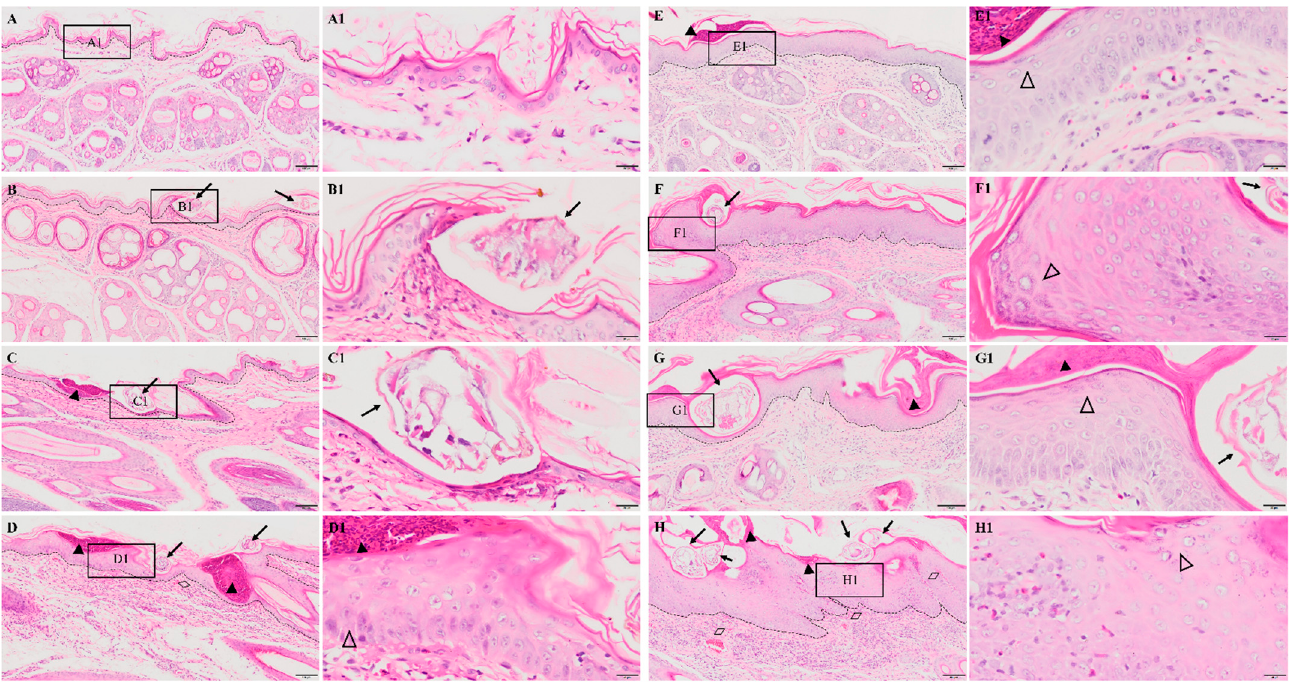
Figure 2. Pathological changes in the posterior toe skin in rabbits. (A): control, (B): 6 hpi, (C): 12 hpi,